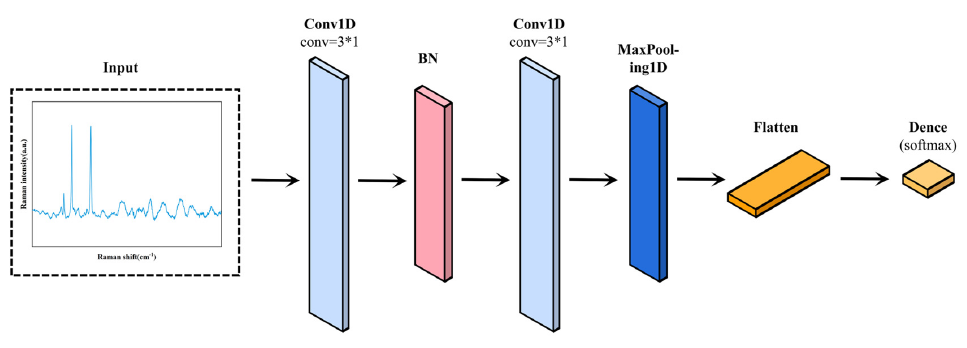
Figure 2. One-dimensional CNN network